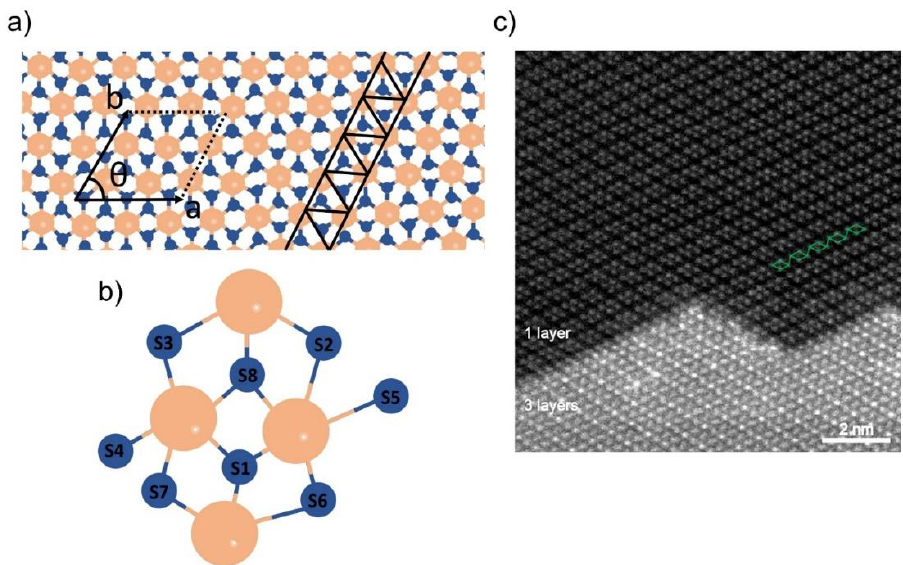
Figure 3. ( a ) Atomic structure of a monolayer ReS 2 . Unit cell and Re chains are indicated. ( b ) Top view of the ReS 2 monolayer shown by unit cell atoms. ( c ) Low magnification ADF image of ReS 2 . The upper part is single-layer with the diamond-shape (DS) phase structure, while the lower part is three-layer stacking. Reprinted with permission from ref. [73]. Copyright 2015 American Chemical Society.